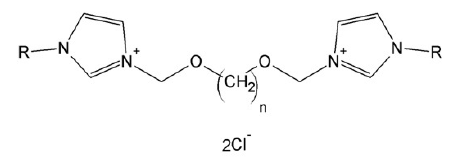
Figure 3. Chemical structure of analyzed compounds.